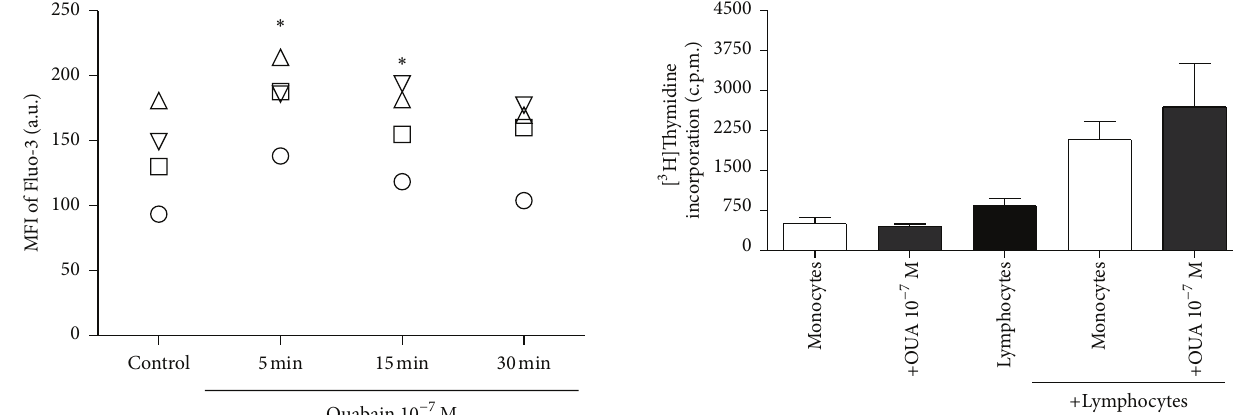
Figure 4: Intracellular calcium in monocytes following ouabain exposure. Cells were loaded with Fluo-3AM (5 𝜇 M) for 10 minutes and then incubated with 10 −7 M of ouabain for 5, 15, and 30 minutes. Scatter plots indicate the means of fluorescence intensity for Fluo-3 in monocytes in each condition. Equal symbols represent the data from the same individual ( 𝑛 = 4 ). ∗ 𝑃 < 0.05 using repeated measures ANOVA with Dunnett’s posttest.